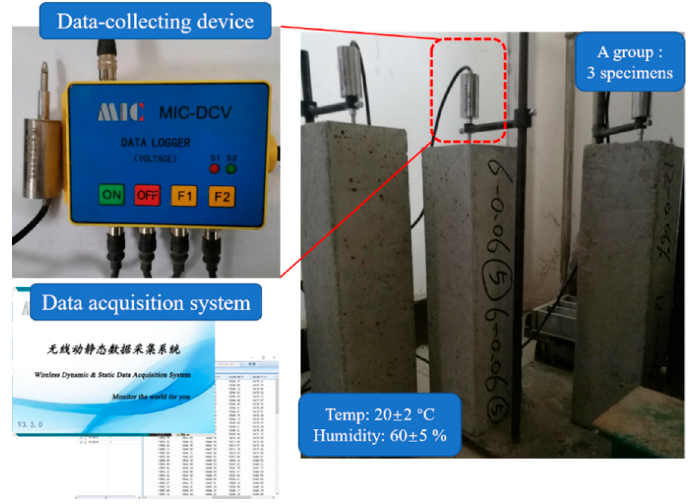
Figure 4. Free shrinkage test equipment.